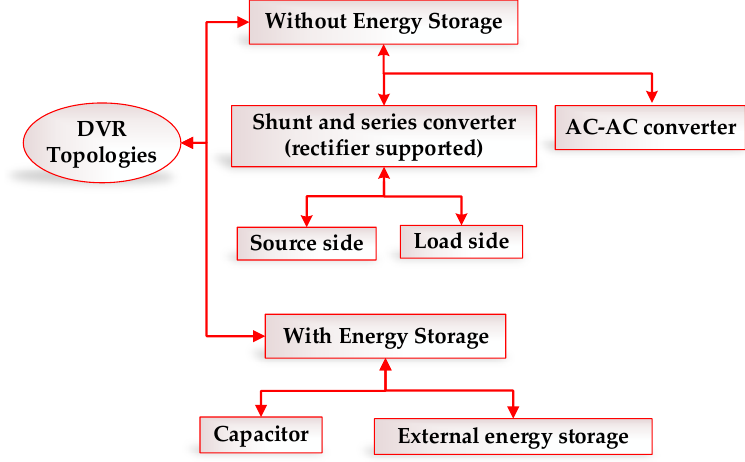
Figure 4. DVR topologies from the energy storage perspective. Based on data from [7,54].